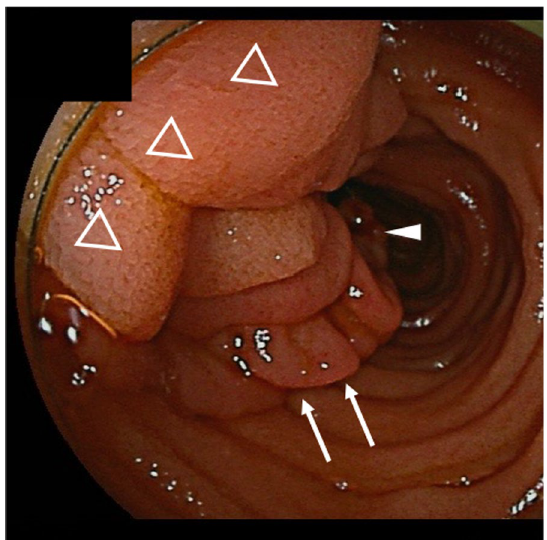
Fig. 2 Double‑balloon endoscopy findings. Double‑balloon endoscopy revealed a large polyp in the proximal jejunum with a long stalk (white arrows). Closed triangle indicates the tip and open triangles show the base